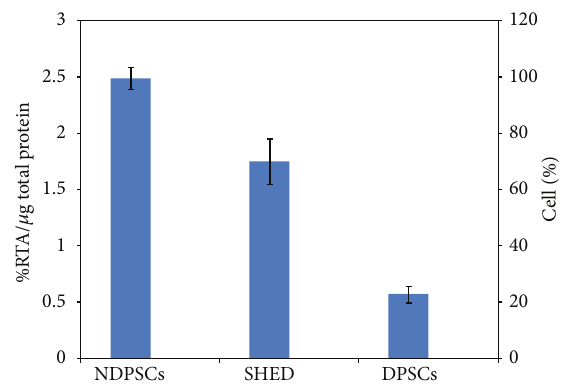
Figure 3: Telomerase activities of NDPSCs, SHED, and DPSCs. The activities were measured by conventional telomeric repeat ampli- fication protocol (TRAP) and relative telomerase activities (RTA) were calculated with respect to the control template equivalent to 0.001 mol/ 𝜇 L